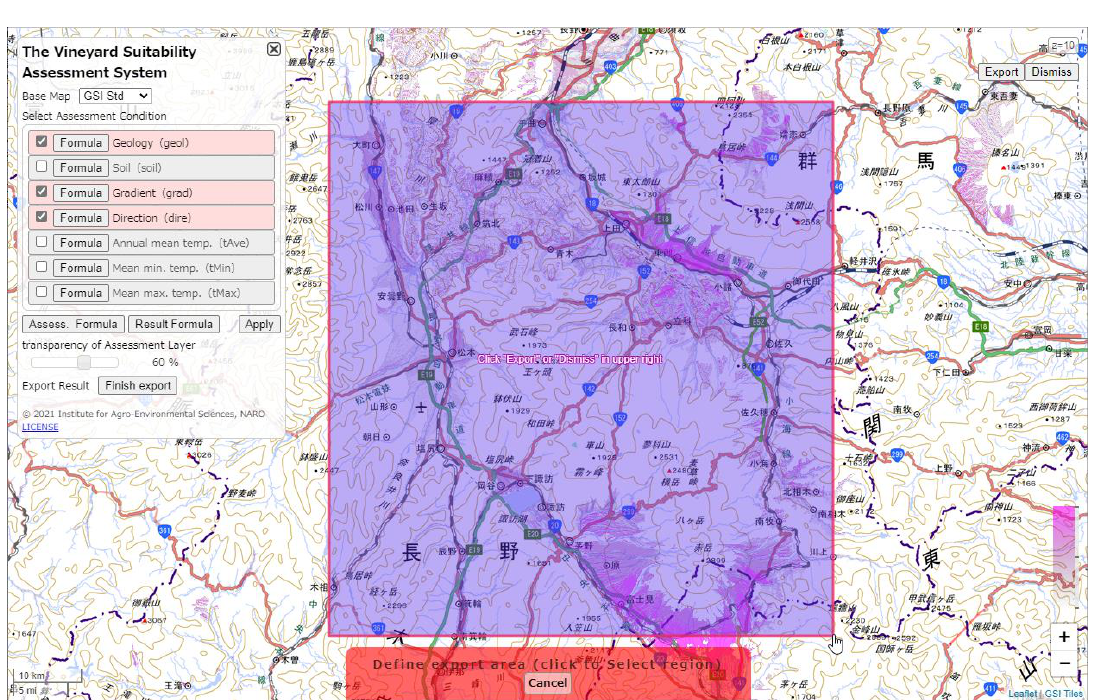
Figure 7 Exporting an evaluation